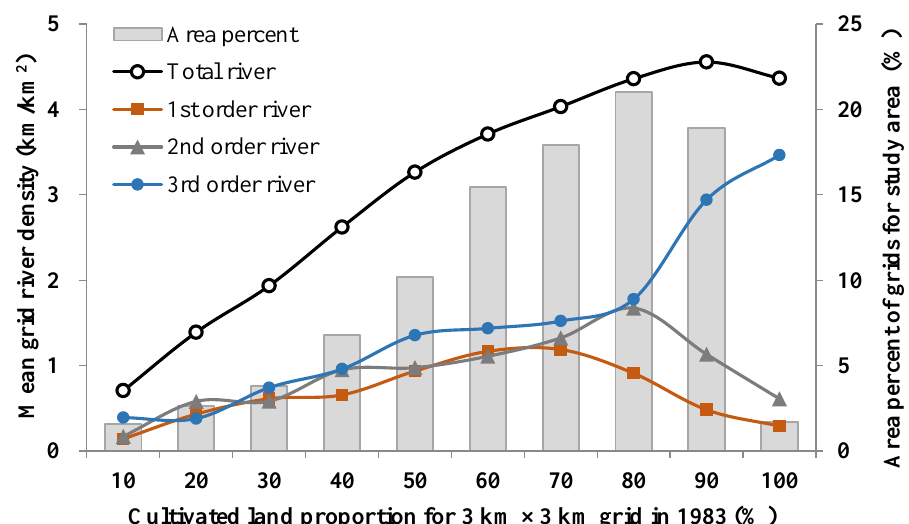
Figure 8. Relationship between the proportion of cultivated land and the evolution of river systems. Note that the label “10” on the horizontal axis shows that the cultivated land proportion for a 3 km × 3 km grid is greater than or equal to 0 and less than 10, and so on.